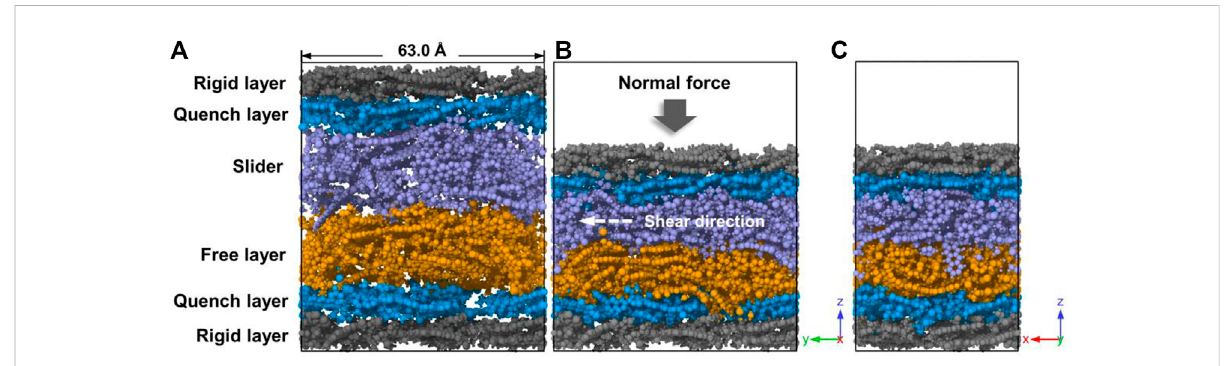
Thesandwichstructuresofthefrictionsystemandthecon fi gurationofthefrictionsystemaftercompression. (A) Thesandwichstructureofthe coal friction system, (B) the left view of the friction system after compression, and (C) the back view of the friction system after compression.